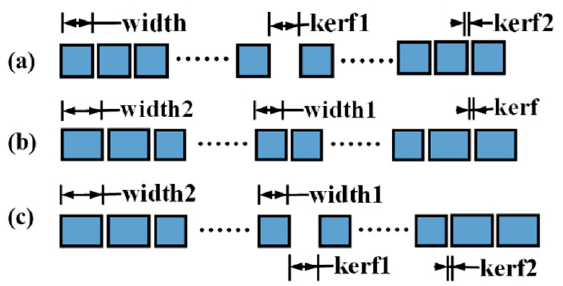
Figure 2. Three types of micro non-uniform linear arrays (MNULAs). ( a ) An MNULA with different kerfs (spacings between adjacent array elements), ( b ) an MNULA with different widths, and ( c ) an MNULA with different kerfs and widths.